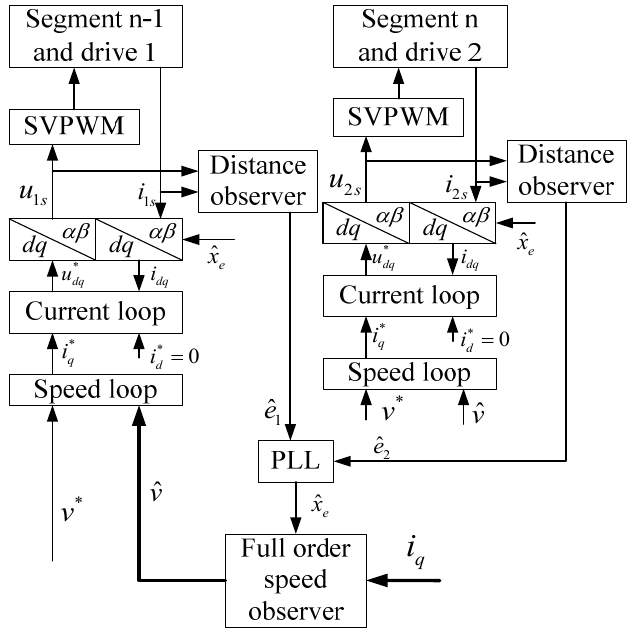
Table 1. The parameters of the WS-PMLM. Motor Data Value